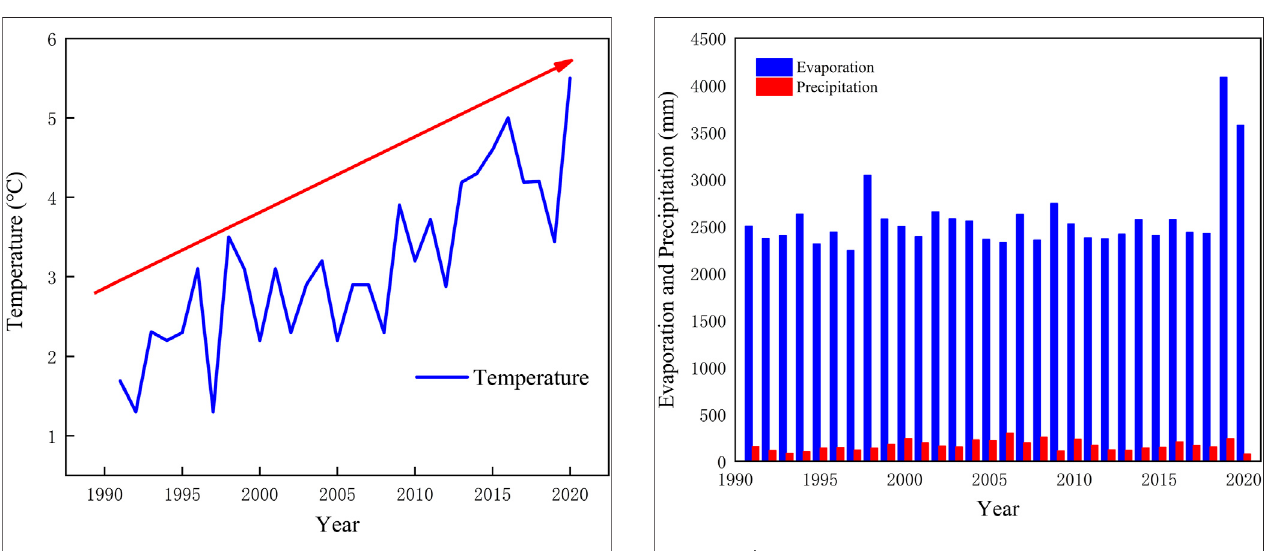
FIGURE 3 | The annual temperature change of Zabuye Salt Lake from 1991 to 2020.